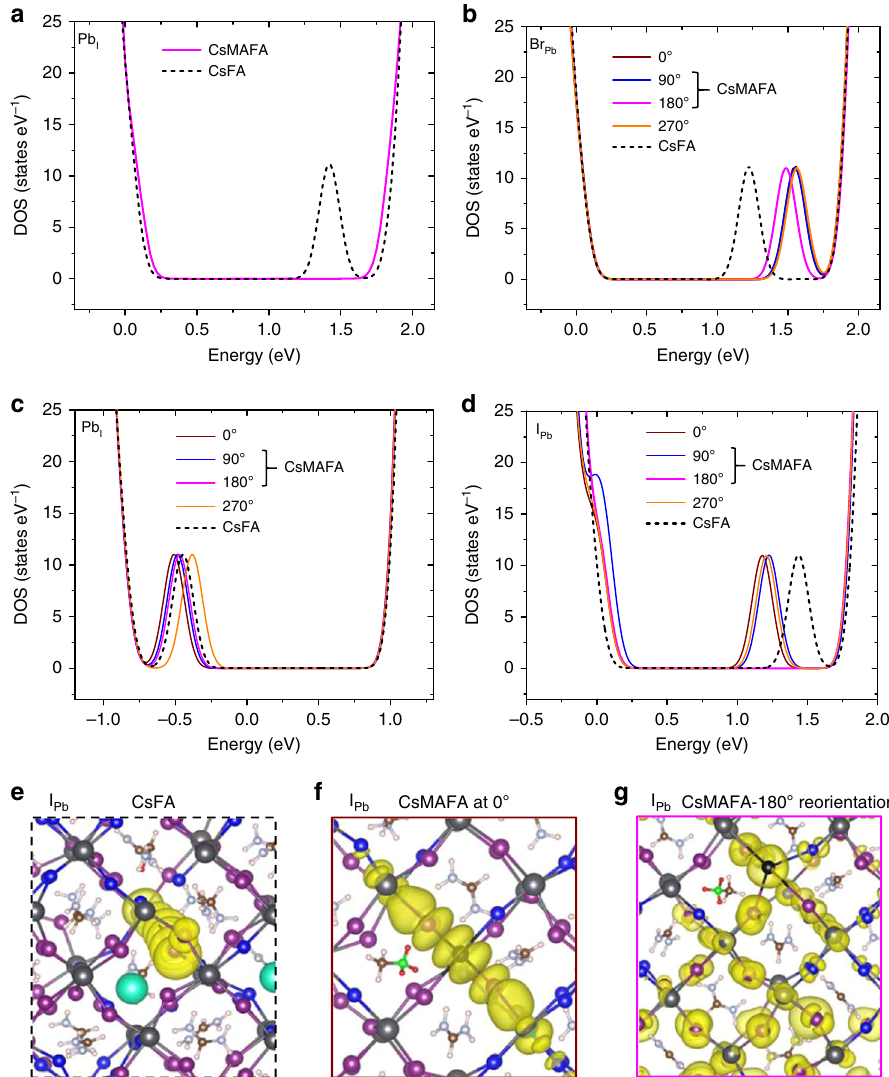
Fig. 4 Effects of MA reorientation on the electronic properties of charged defects. a Density of states (DOS) of CsFA and CsMAFA perovskites in the case of defect (Pb I ) that in-gaps states are present in CsFA perovskite, but not in CsMAFA perovskite, regardless of the reorientation direction. b – d Density of states (DOS) of CsFA and CsMAFA perovskites in the cases of defects (Br Pb , Pb i , and I Pb ) that introduce in-gap states in both perovskites, but the reorientation of MA cation renders shallower trap levels. e – g Wave functions of perovskites with the I Pb defect: CsFA perovskite ( e ) and CsMAFA perovskite when the MA cation is randomized at 0 o ( f ) or is reoriented at the lowest energy direction 180 o ( g